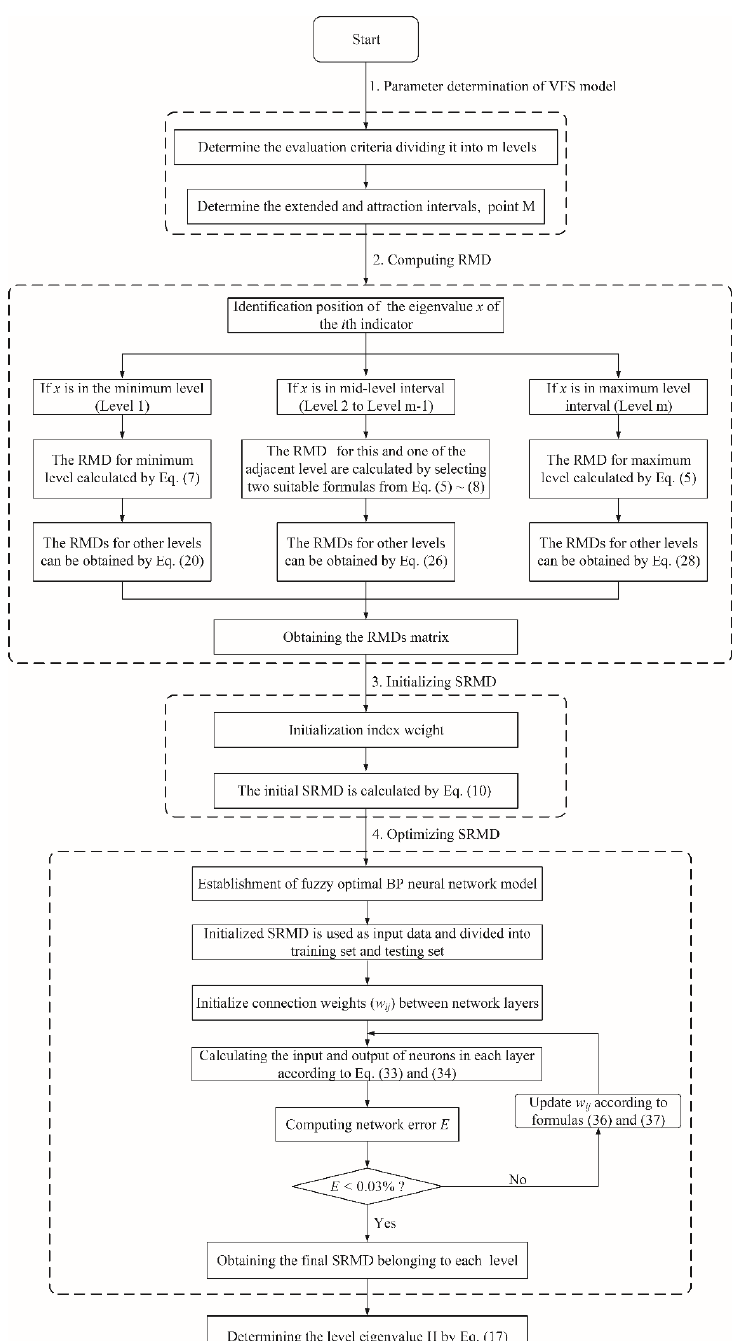
Figure 8. Flow chart for improving the VFS assessment and prediction method.